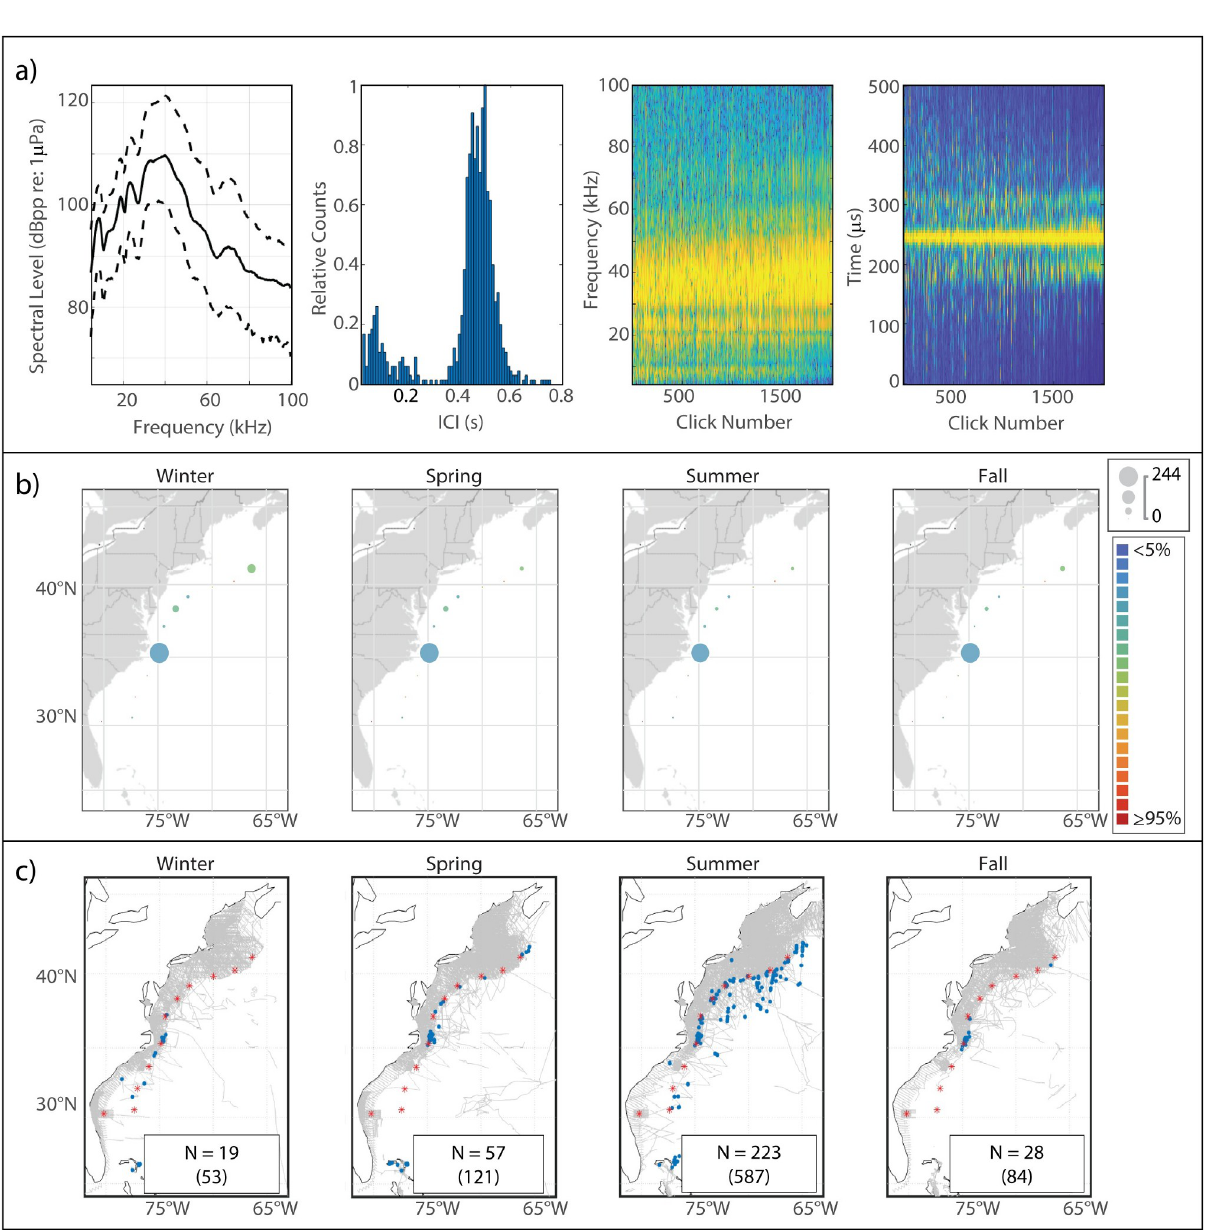
Fig 7. Results for Cuvier’s beaked whale showing click type (a), acoustic presence (b), and historical sightings (c). Subplots as in Fig 2.